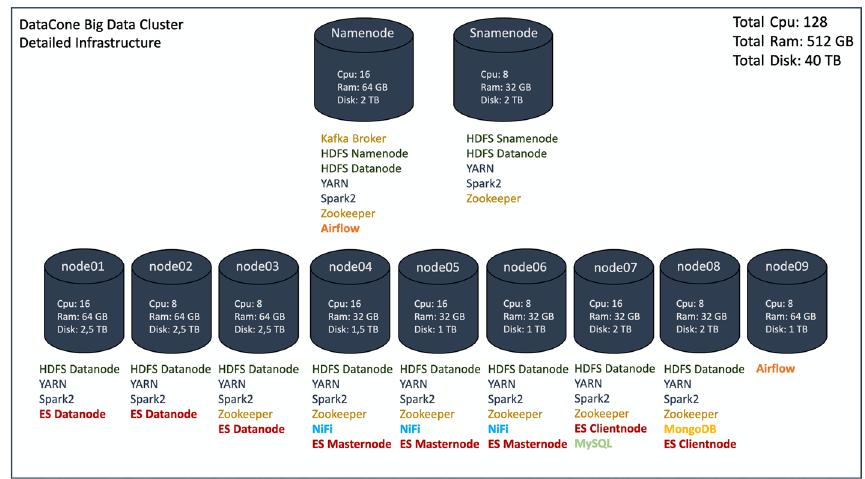
Fig. 1 Cluster design of DataCone with master node to manage the cluster, secondary master node to ensure high availability, and 9 slave nodes. The infrastructure of DataCone is designed for manufacturing companies considering data frequency, data volume, and sector-specific IoT protocols. Open-source big data software is distributed over the nodes to optimize hardware cost. The main logic of the infrastructure depends on scalable structure. When data volume is increased or new devices are needed to be added, infrastructure will be easily scaled by adding new nodes